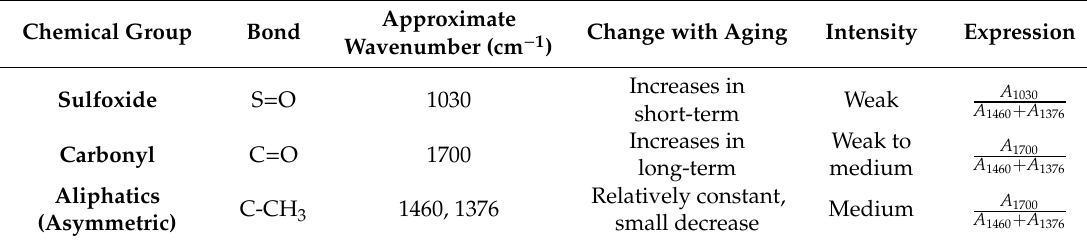
Table 1. Fourier transform infrared (FTIR) bands with bitumen aging [27].